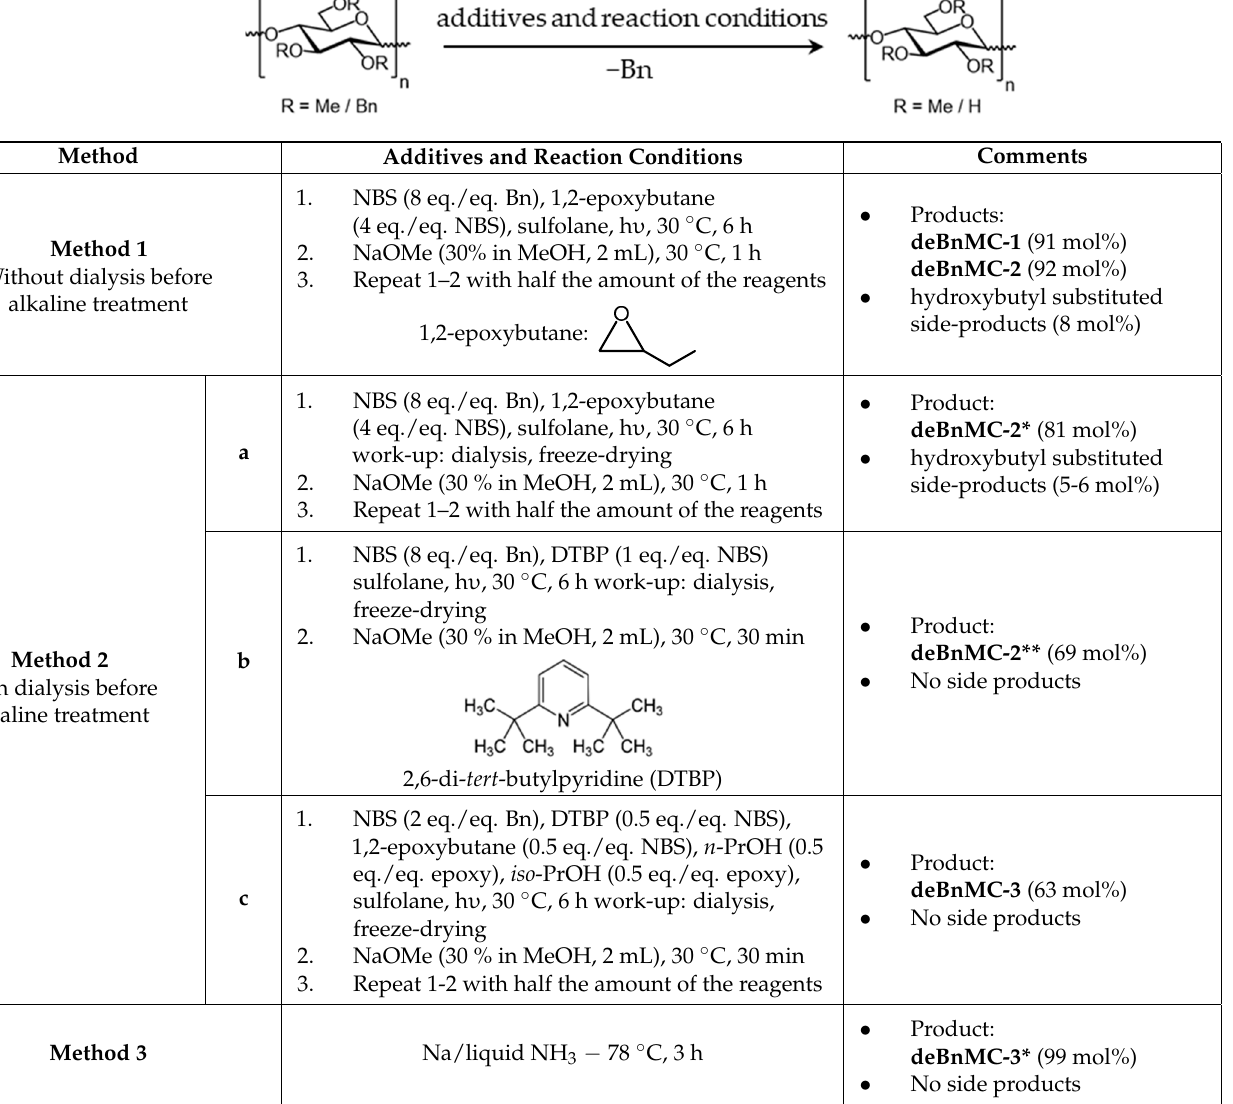
Table 1. Debenzylation Methods, reaction conditions and additives. Products’ names are shown in bold and the stars are part of the products’ names, such as deBnMC-3* .